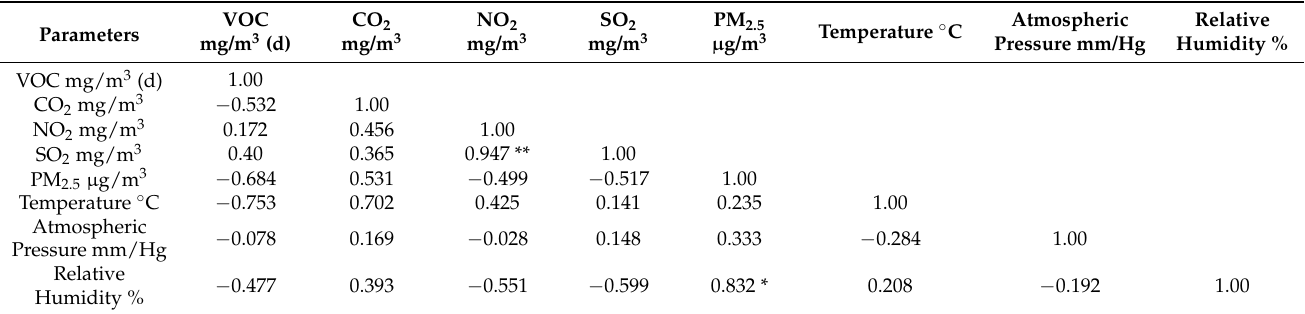
Table 3. Relationship between air quality and meteorological parameters across the study area (dry season). Parameters